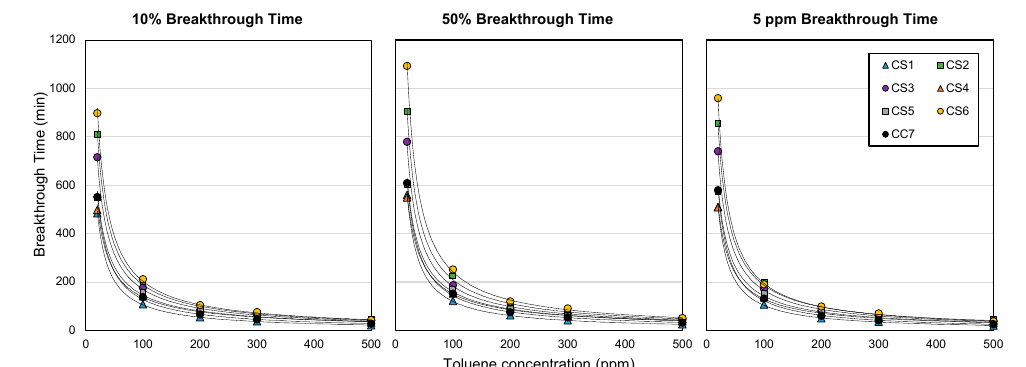
Figure 5. Breakthrough times as a function of toluene concentration by cartridge type. Cartridge type (ACF composition): CS1 (100% AF1); CS2 (100% AF2); CS3 (100% AF3); CS4 (100% AF4); CS5 (100% AF5); CS6 (100% AF6); CC7 (71% AF1/29% AC1).